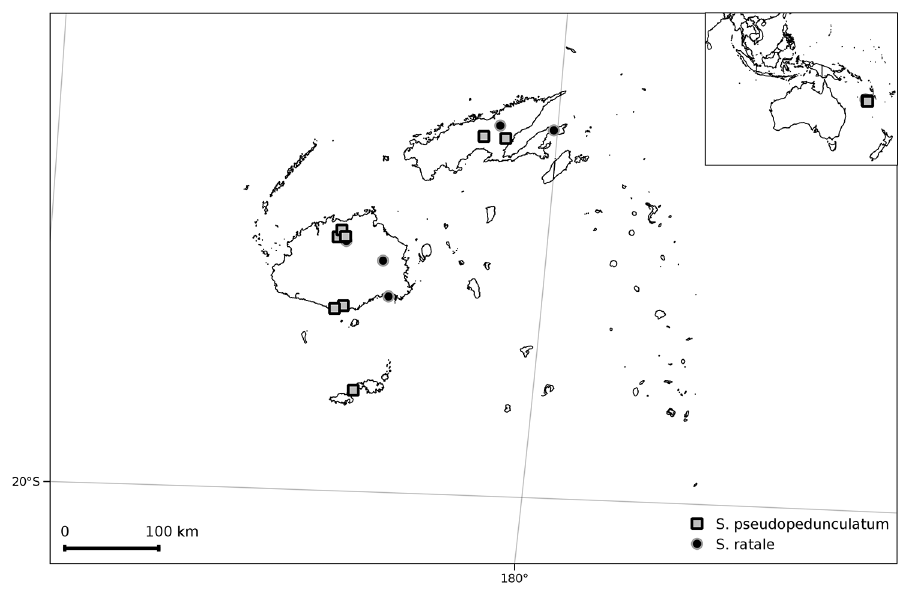
Figure 9. Distribution of Solanum pseudopedunculatum and S. ratale .